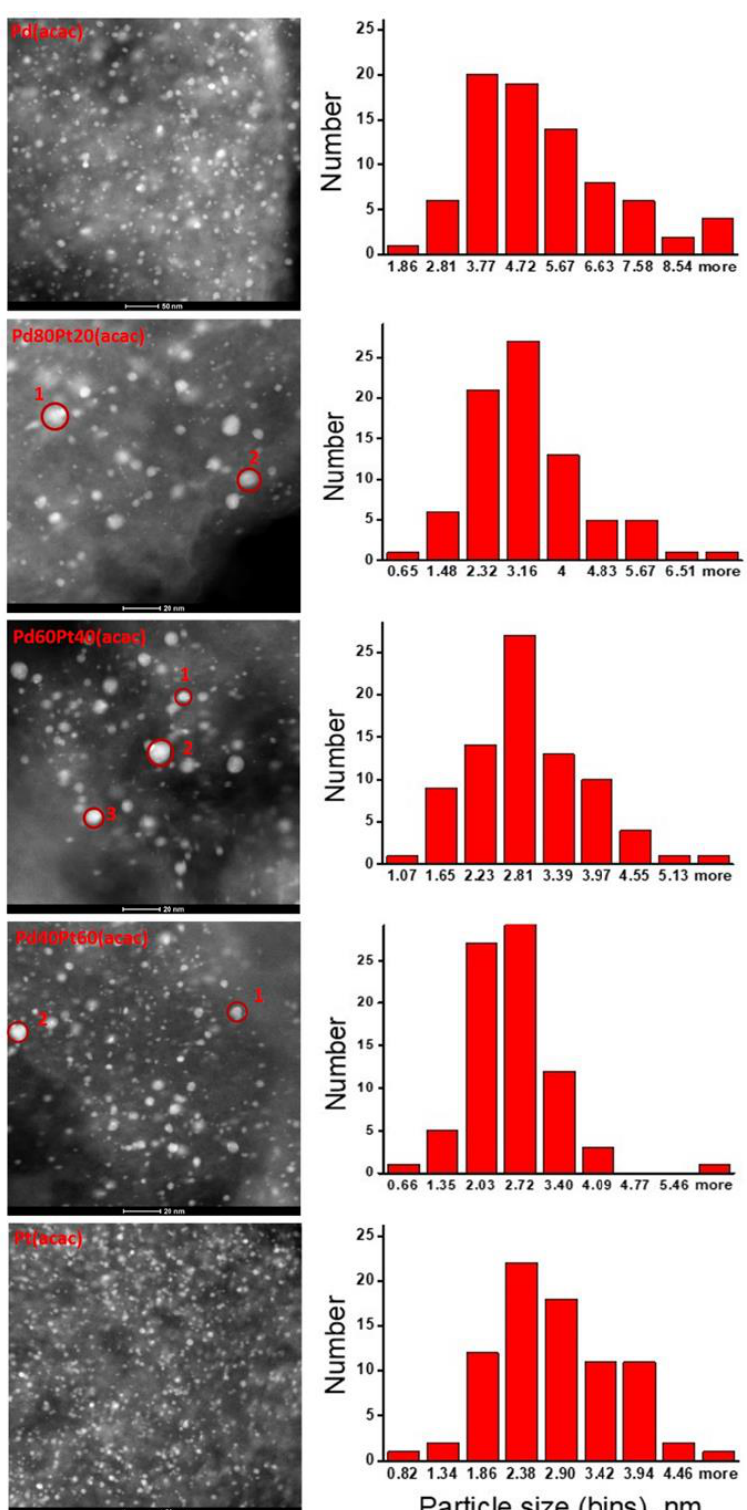
Figure 4. TEM images and size distributions of Pd–Pt(ex-acac) / C catalysts. Selected EDS areas: for